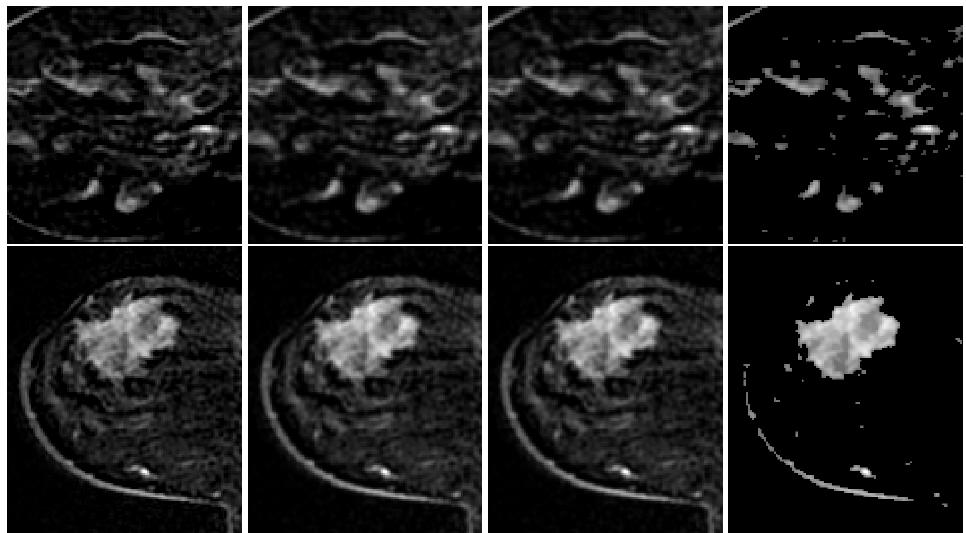
Figure 4. Examples of pre-processing steps on two breast lesions (one per row): ( 1st column ) DCE- MRI breast image (after cropping); ( 2nd column ) Gaussian smoothing result; ( 3rd column ) centering result; and ( 4th column ) gamma correction result. With respect to the position in the DCE-MRI sequence, all images have been rotated 90° clockwise, in order to improve the graphic representation and allow all the images relating to a specific lesion to be displayed in a single